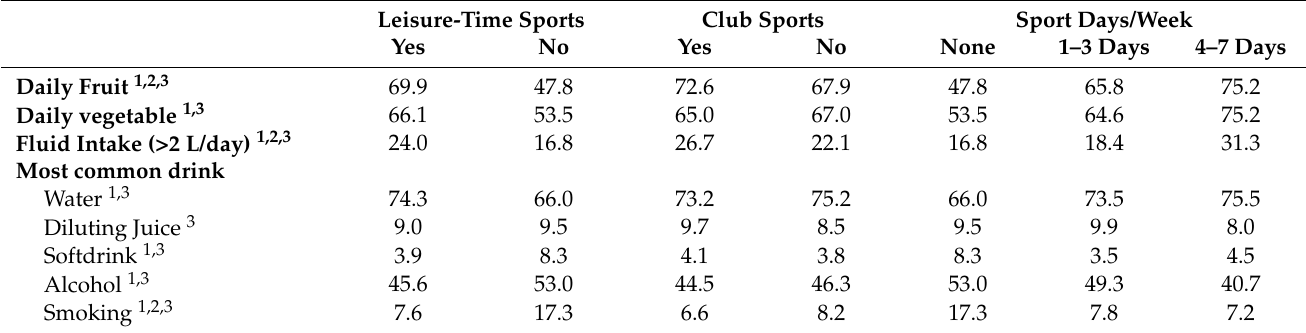
Table 7. Dietary habits by sports participation. Values are in prevalence (%).